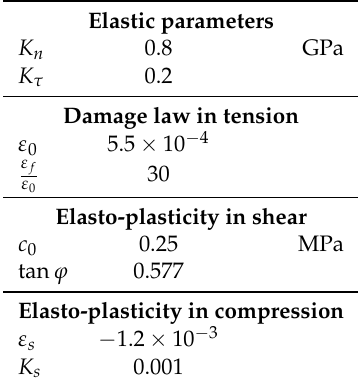
Table 4. Calibrated parameters of the DEM model for the cementitious